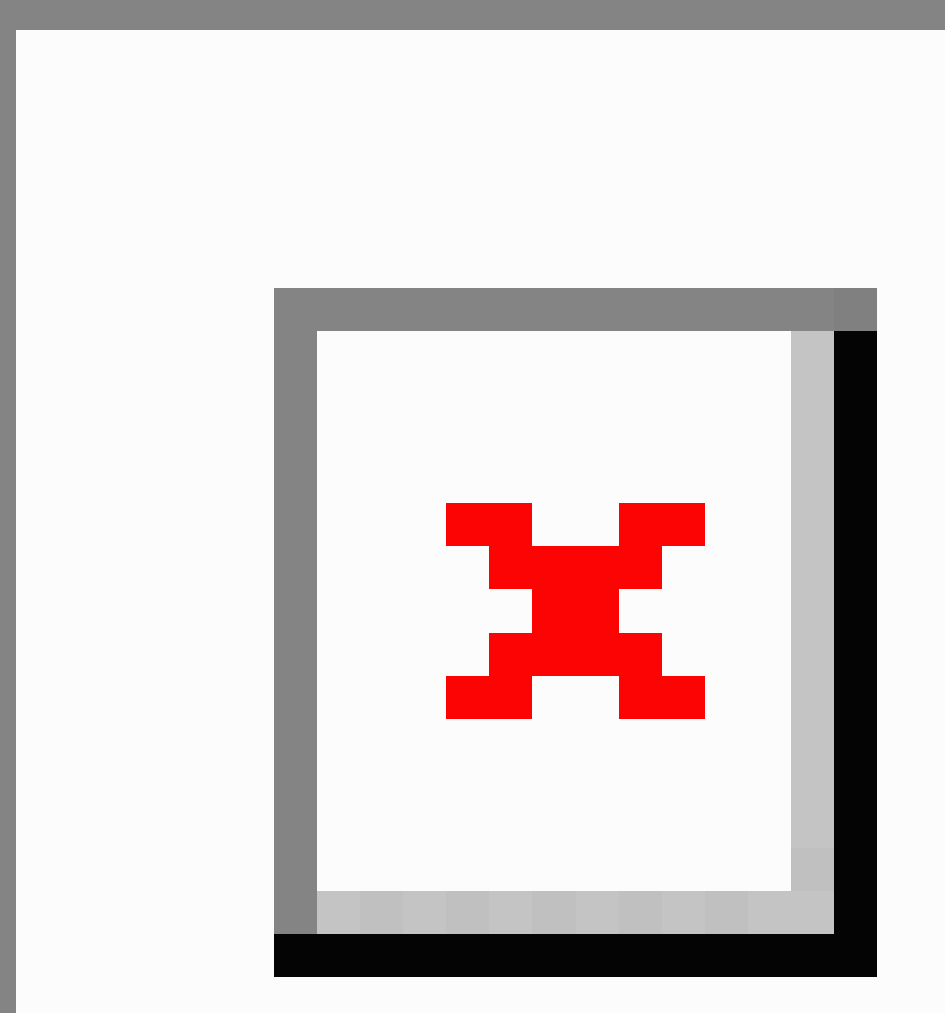
Figure 2. Data flow. API: application program interface; GPS: global positioning